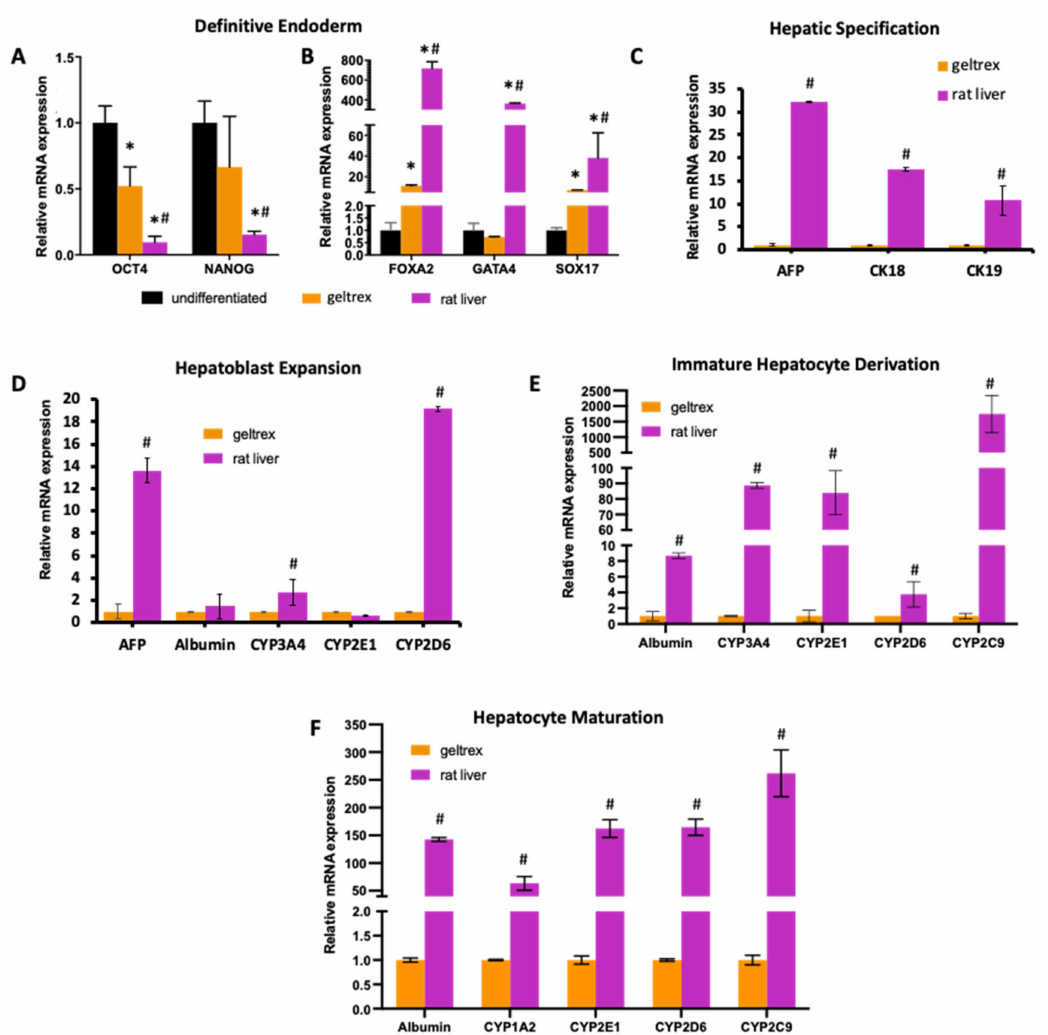
Figure 2. mRNA expression levels of key markers specific to each differentiation stage. qRT-PCR analysis showing mRNA expression of ( A ) pluripotency and ( B ) endoderm markers at the DE stage. ( C ) mRNA expression of early hepatic markers at the HS stage. mRNA expression of mature hepatic markers at ( D ) the HE stage, ( E ) the IHC stage, and ( F ) the HM stage, relative to undifferentiated iPSCs. (* indicates statistically significant differences compared to undifferentiated iPSCs ( p < 0.05); # indicates statistically significant differences in the decellularized rat liver group compared to the geltrex group ( p < 0.05).) For rat liver data, samples from three scaffolds at DE, HS, HE, IHC, and IHC+ stages were analyzed. For geltrex data, at least three different differentiations at each stage were used in the